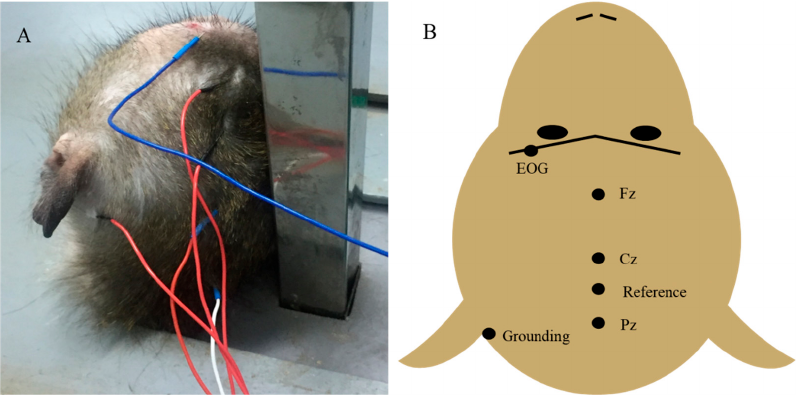
Figure 4. Experimental photos of ABR detection. ( A ). Photos of macaque monkeys during P300 recording, ( B ). Individual electrodes were inserted into the scalp according to the illustration.